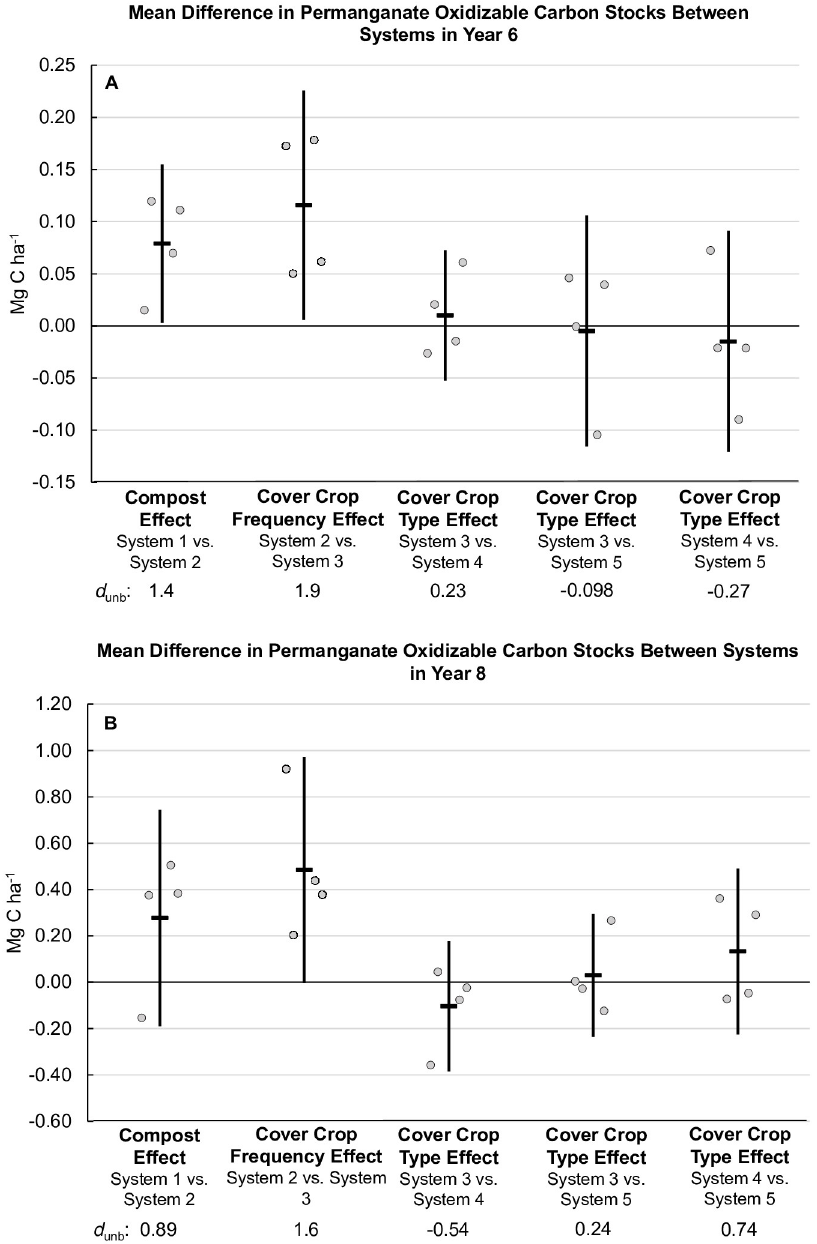
Fig 8. Mean difference in permanganate oxidizable carbon stocks between systems in years 6 and 8. Measurements were taken at the 0 to 6.7 cm depth for years 0 and 6 (A), and the 0 to 30 cm depth in year 8 (B). Systems differed by annual compost additions (0 vs. 7.6 Mg ha -1 before each vegetable crop), cover crop type (legume-rye, mustard, or cereal rye alone) and cover cropping frequency (quadrennially vs. annually planted). Error bars are 95% confidence limits. Individual data points for replicates 1 through 4 of each system are clustered in order from left to right around the mean, which is represented by the horizontal lines. The standardized effect size (Cohen’s unbiased d , d unb ) is shown below the x-axis